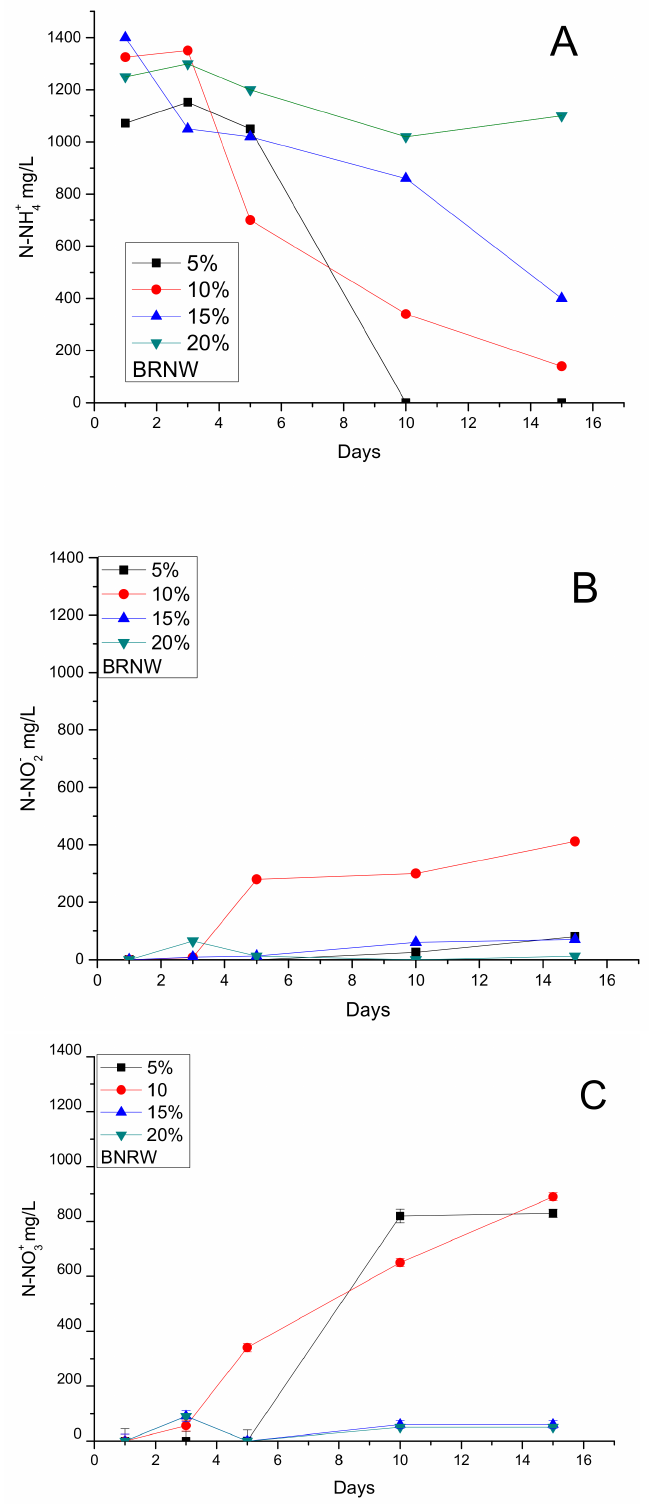
Figure 10. Inhibition of nitrification by BRNW. Performance of ( A ) N-NH 4 + mg/L, ( B ) N-NO 2 − mg/L and ( C ) N-NO 3 − at different BRNW